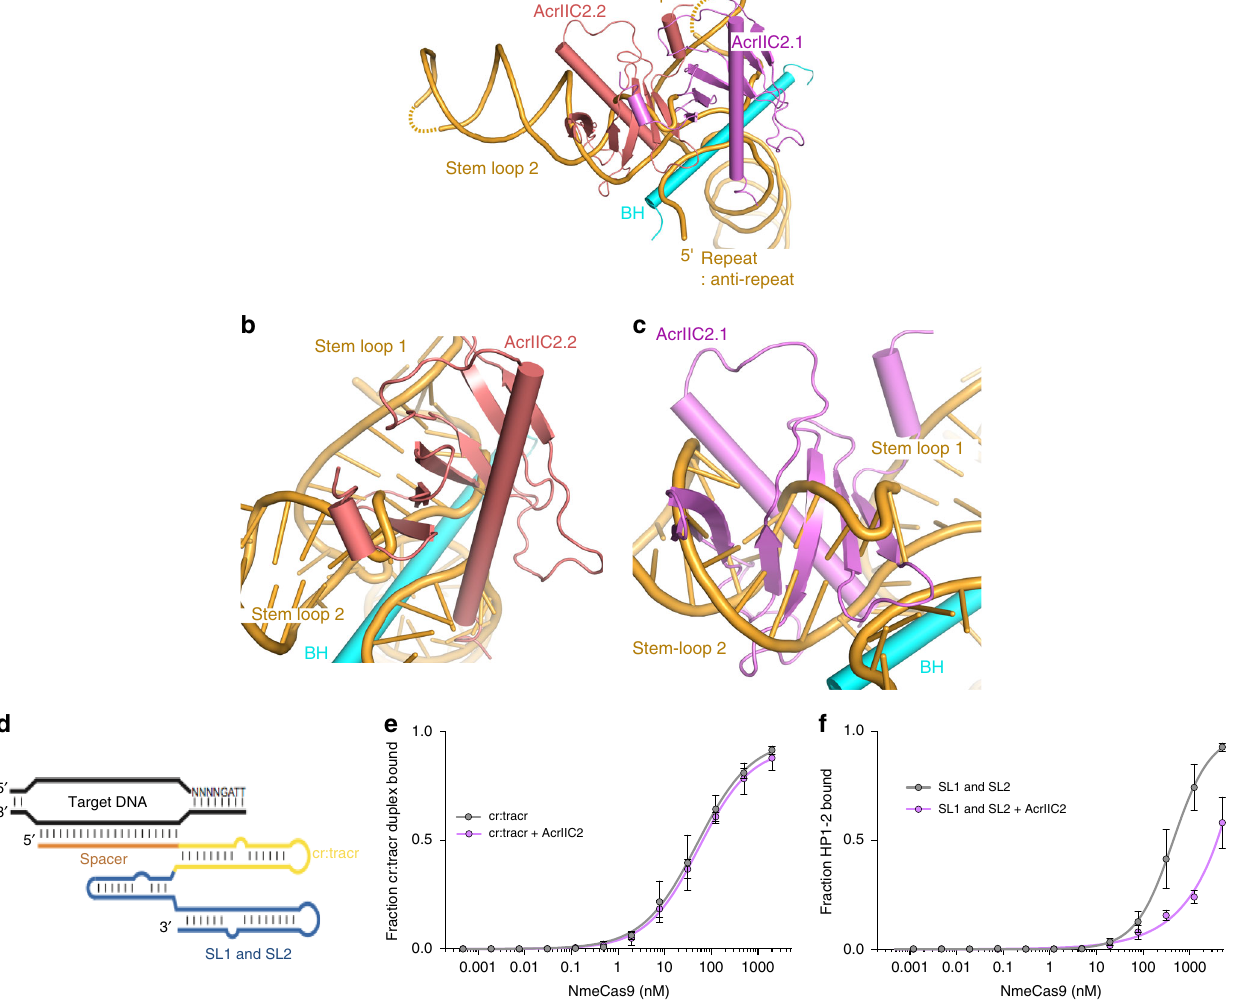
Fig. 5 AcrIIC2 Nme blocks binding of the sgRNA by occluding the binding sites for stem loops 1 and 2. a Structural comparison between AcrIIC2 Nme - Nme1Cas9 and Nme1Cas9-sgRNA binary complex based on the superimposition of bridge helix regions. Monomer AcrIIC2.2 occupies the major groove where stem loop 2 should bind ( b ) while AcrIIC2.1 occupies the positions of stem loop 1 and the seed region ( c ). d Schematic sgRNA, indicating the repeat: anti-repeat (cr:tracr) and 3 ′ stem loop 1 and 2 (SL1, SL2). Radiolabeled sgRNA truncations were incubated with Nme1Cas9-AcrIIC2 Nme complex and the fraction of protein-bound RNA was determined by nitrocellulose fi lter binding when only the cr:tracr ( e ) or 3 ′ stem loops 1 and 2 ( f ) were present. Source data are provided as a Source Data fi